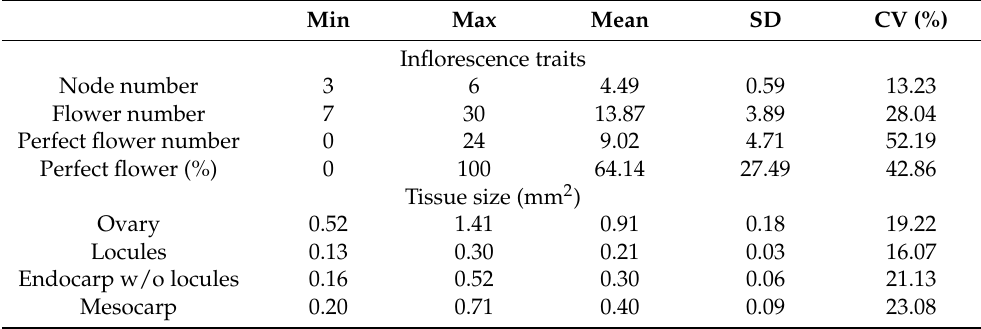
Table 1. Overall variability in inflorescence and ovary parameters for all genotypes (parents and progenies) in the two years of